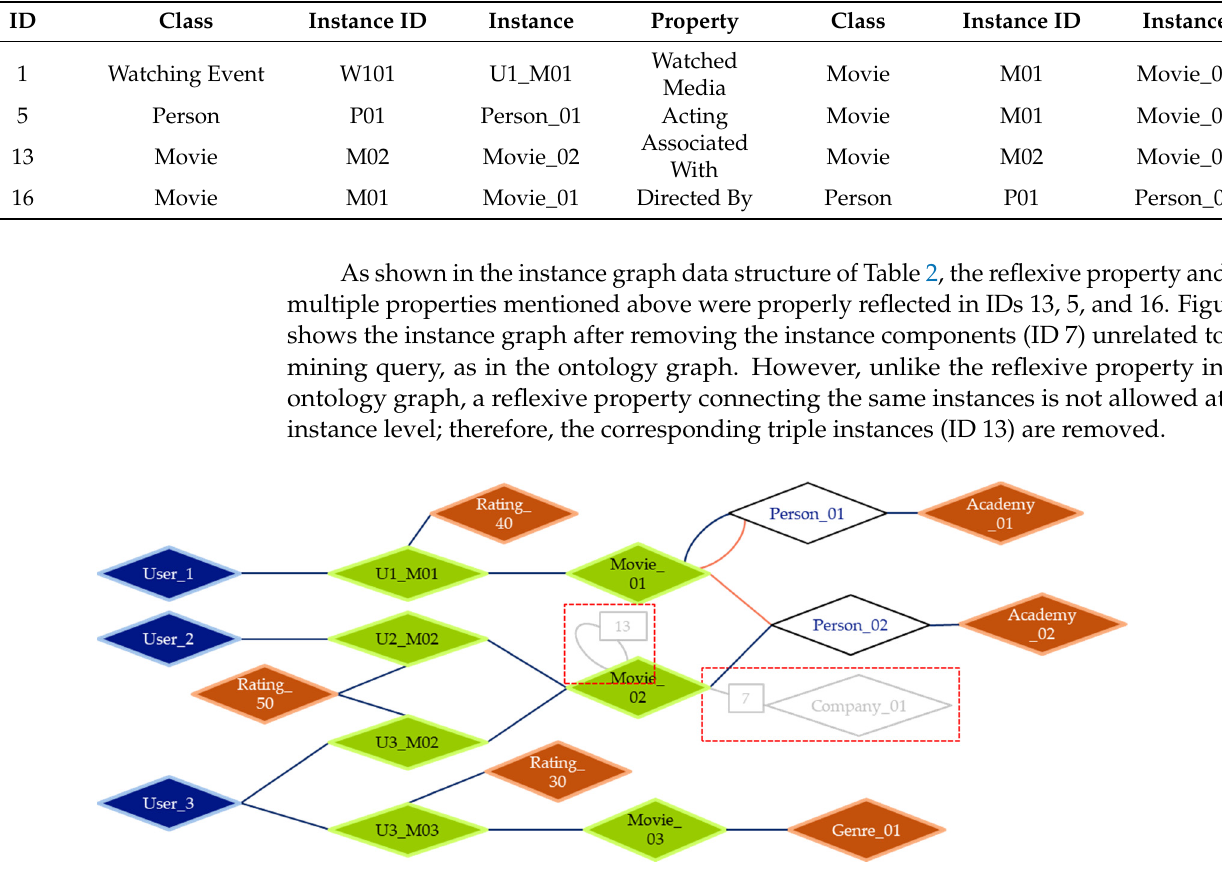
Figure 7. Instance graph after removing irrelevant graph components and reflexive property. Table 2. Instance graph data structure.